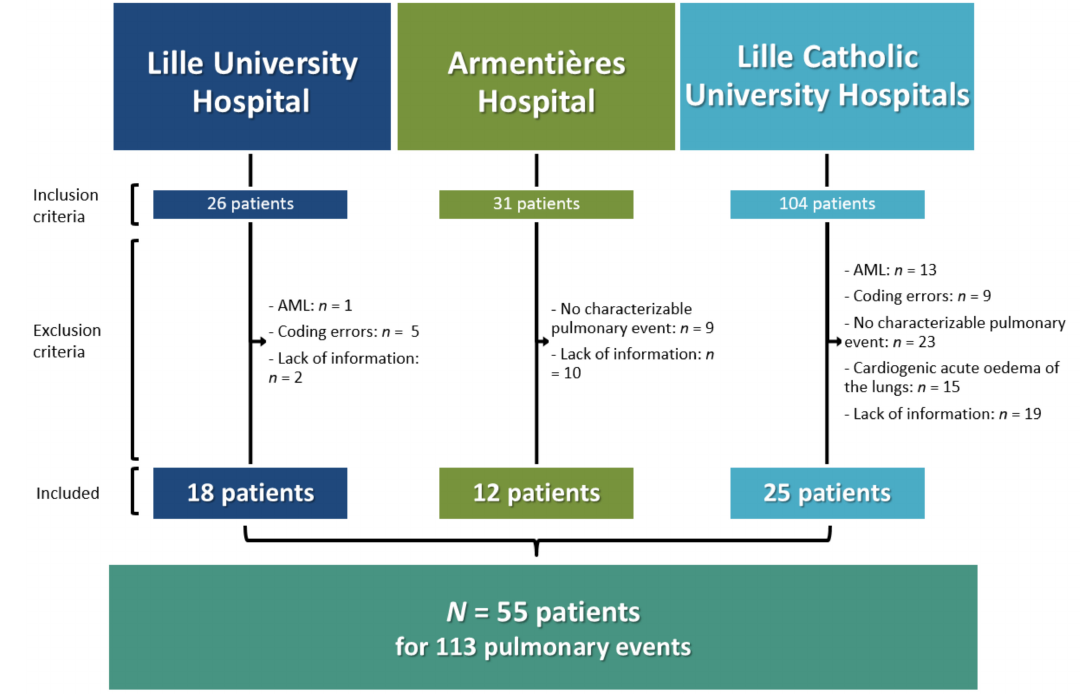
Figure 1. Patient inclusion flow chart. (AML: MDS had worsened to acute myeloid leukaemia when the pulmonary event occurred).